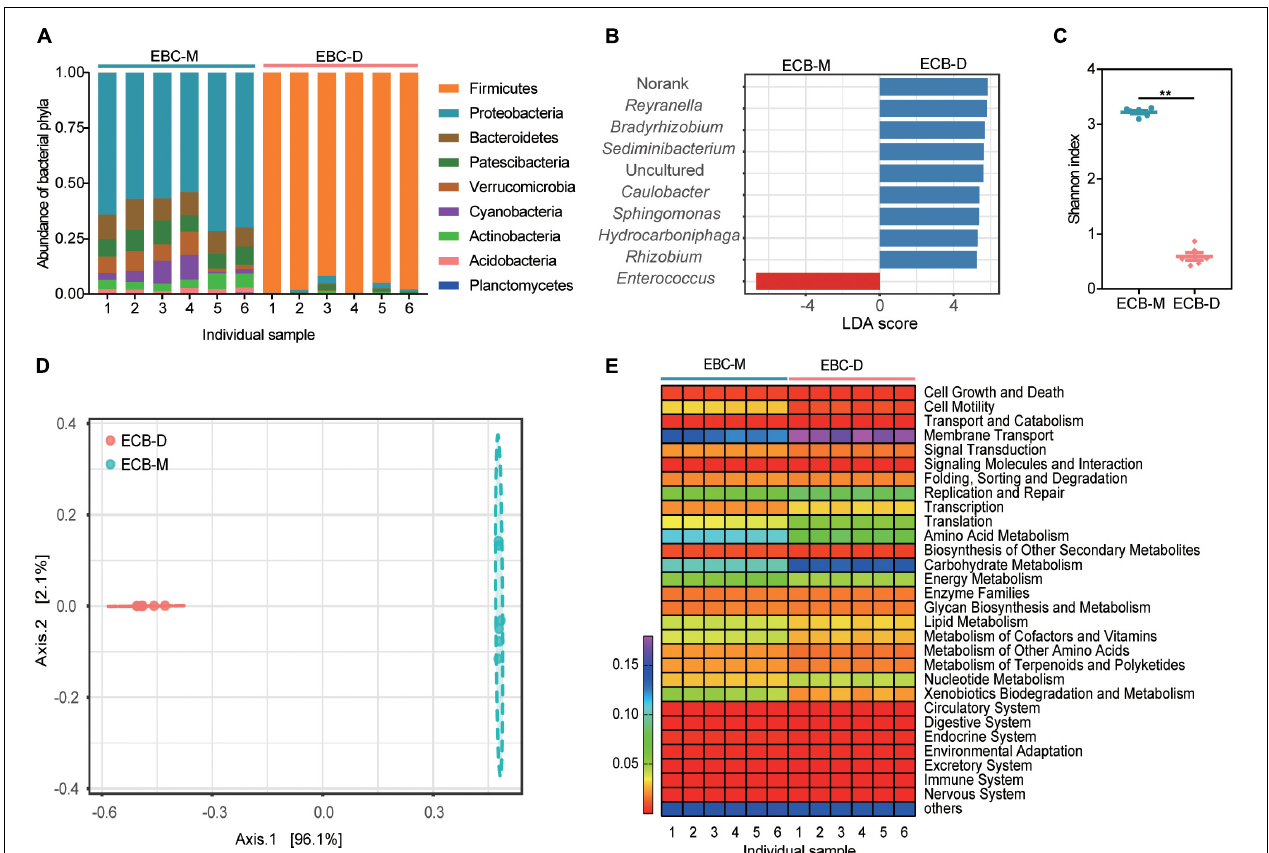
FIGURE 1 | Gut microbial diversity and community composition in the ECB larvae fed with an artificial diet (ECB-D) or maize plants (ECB-M). (A) Relative abundance of microbiota in both strains at the phylum level. The number of x -axis indicates individual gut sample. (B) Linear discriminant analysis effect sizes (LEFSe) for the top 10 bacterial genus that differed significantly in relative abundance between ECB-D and ECB-M. (C) α -diversity comparison based on the Shannon diversity index, using a t -test to determine significant differences (** P < 0.01). Horizontal lines indicate the mean ( ± SE) of biological replicates. (D) Principal coordinate analysis (PCoA) plot generated using OTU metrics based on Bray-Curtis distance. The variation explained by the PCoA axes is given in parentheses. (E) Heatmap showing the main function of microbiota present in the larval gut of ECB-D and ECB-M with different abundance.